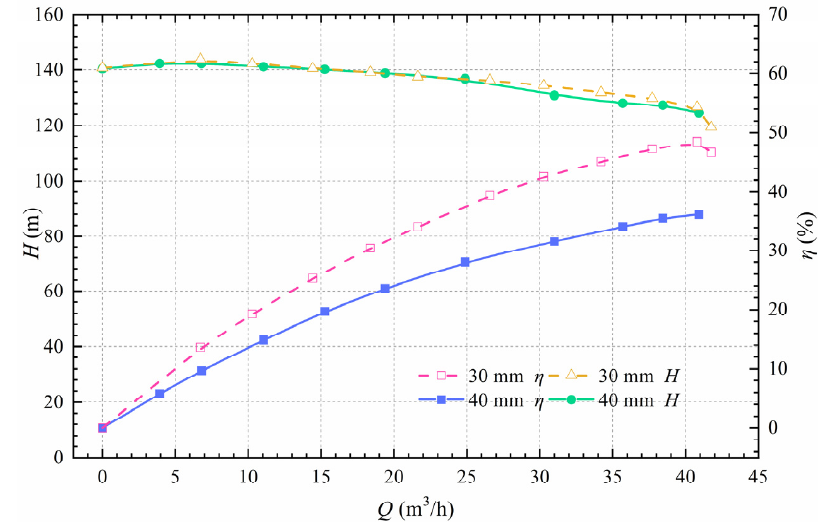
Figure 21. Comparison of pump performance.